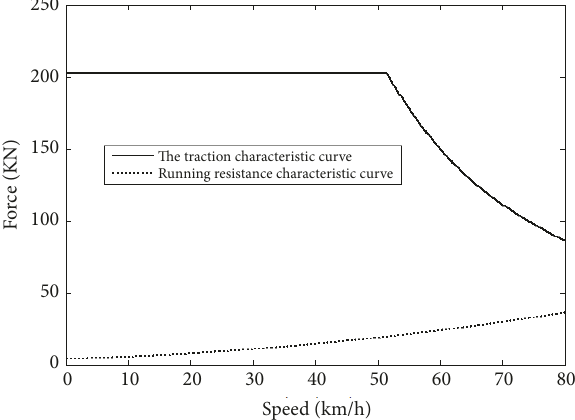
Figure 4: The traction characteristic curve and running character- istic resistance